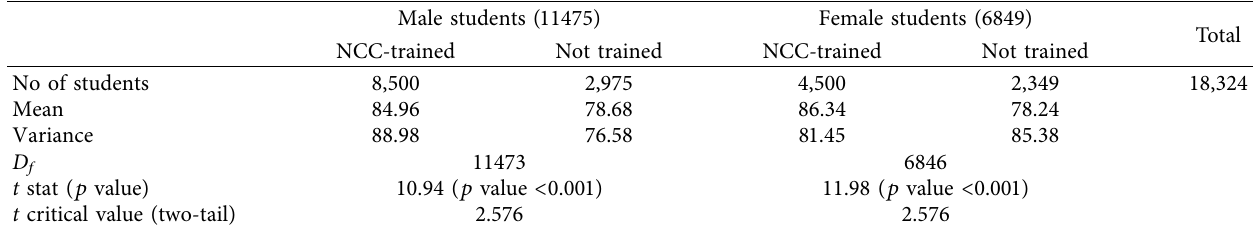
Table 6: Results of personality development qualities among male and female cadets in Madras group.